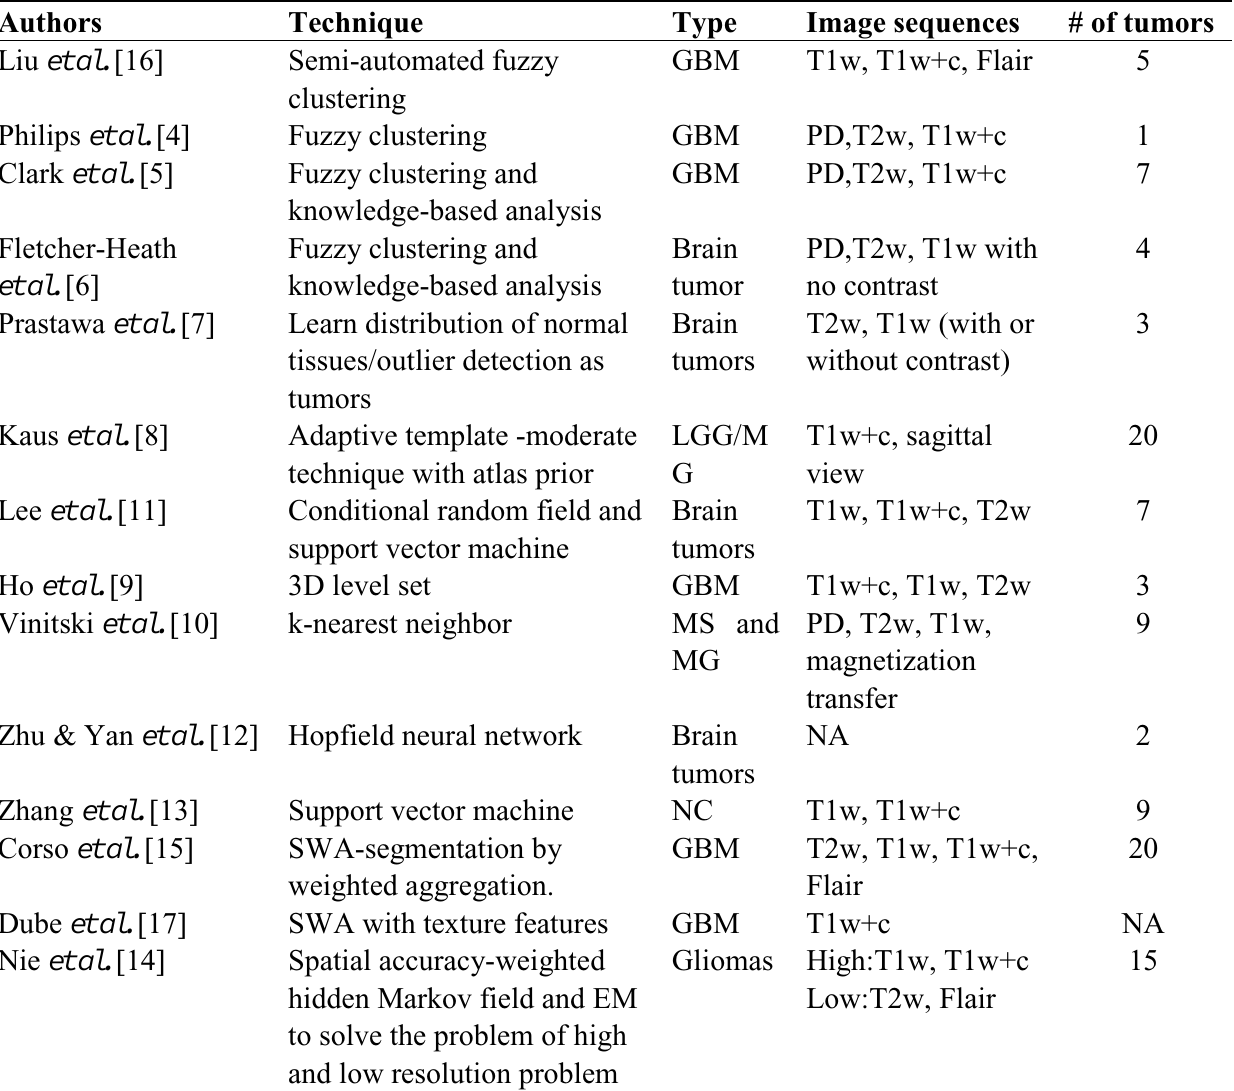
Table 1. Summary of related methods in brain tumor segmentation. The type abbreviations are NC: Nasopharyngeal carcinoma; MNG: Meningiomas; MG - malignant gliomas; MS – multiple